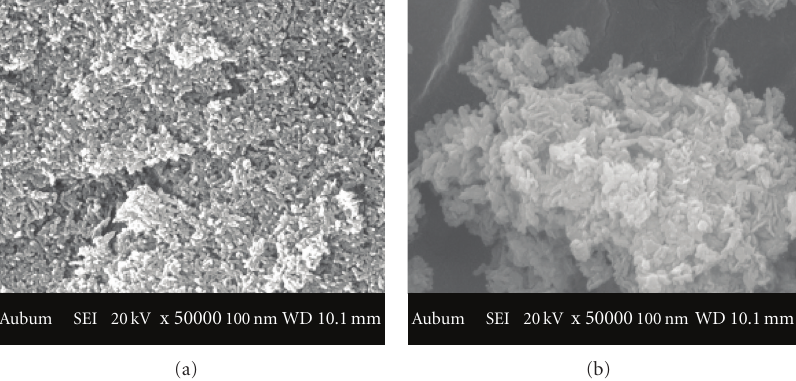
Figure 2: SEM images of (a) lab synthesized nano-HA and (b) commercial Aldrich-HA.